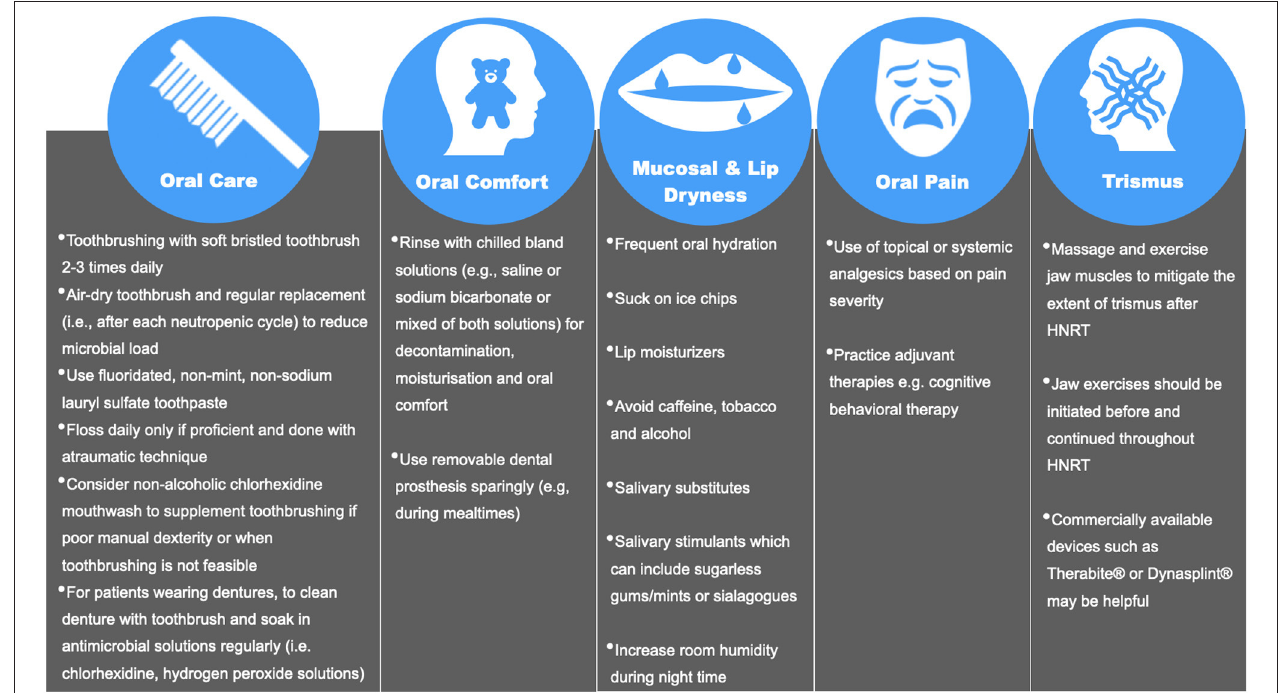
FIGURE 1 | Oral care instructions during and after anti-neoplastic therapy [54, 63, 92–101].